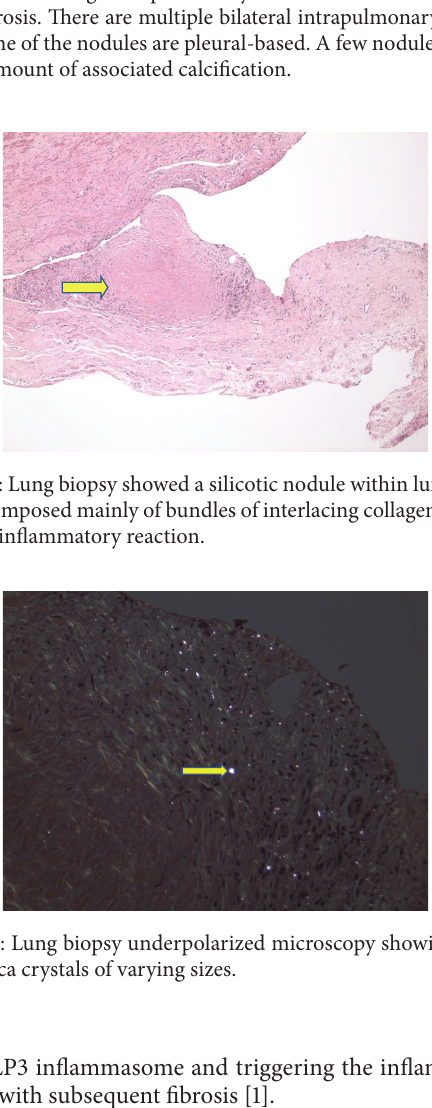
Figure 1: Chest X-ray showed a right lung infiltrate and moderate right pleural effusion, small left pleural effusion, bilateral small irregular opacities, and pleural thickening.